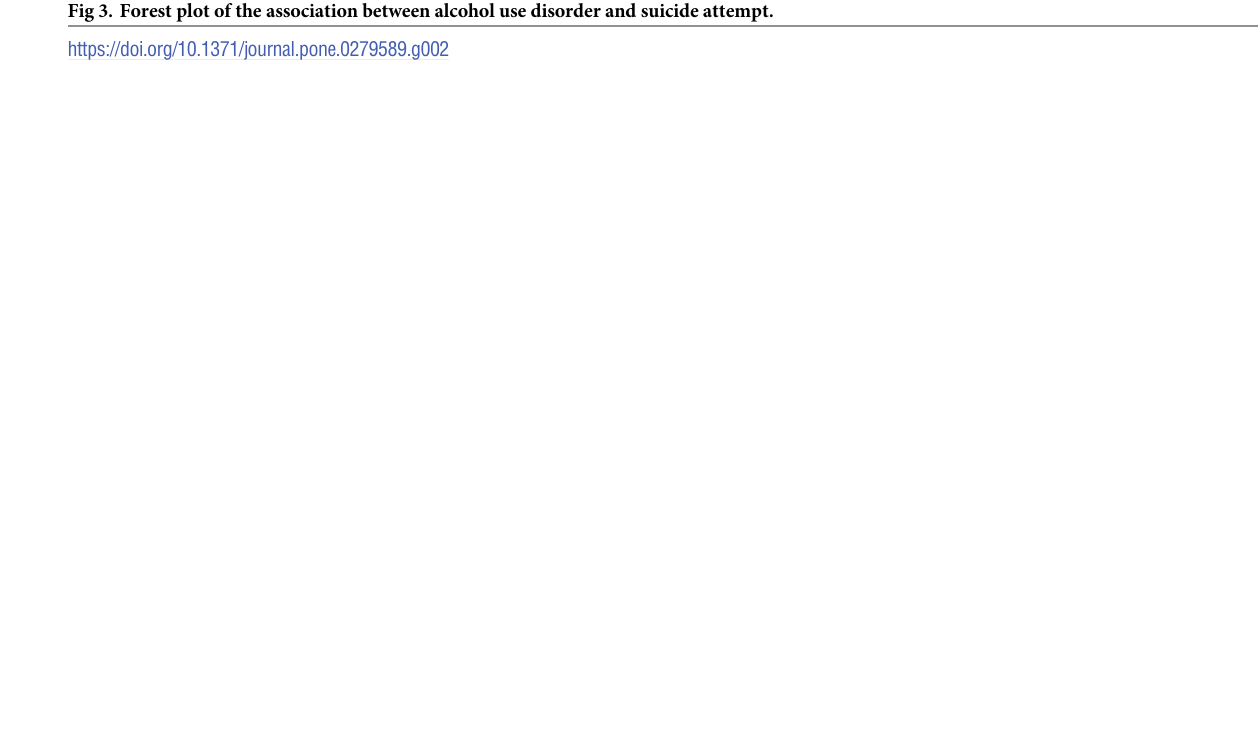
PLOS ONE | https://doi.org/10.1371/journal.pone.0279589 December19,